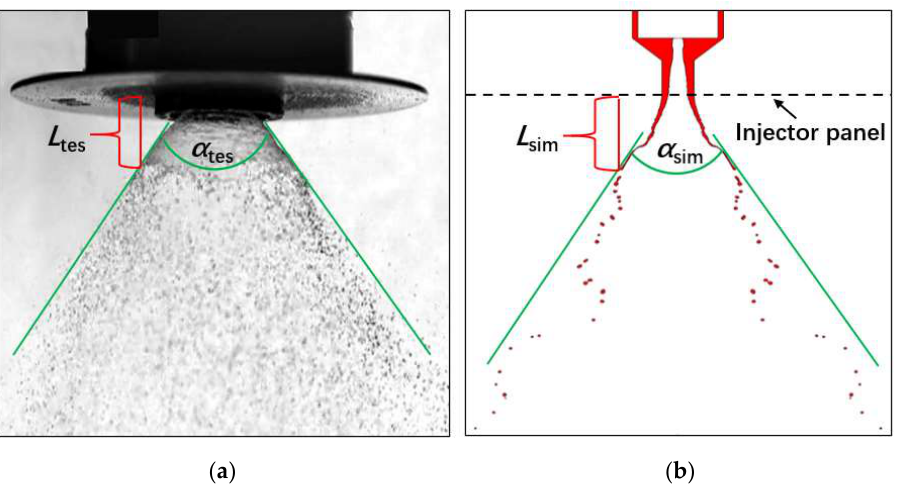
Figure 4. Comparison of validation between experimental image ( a ) and simulated result ( b ) by high-speed camera, with umbrella shape, similar spray angle (α tes and α sim ), and breakup length ( L tes high-speed camera, with umbrella shape, similar spray angle ( α tes and α sim ), and breakup length and L sim ). ( L tes and L sim